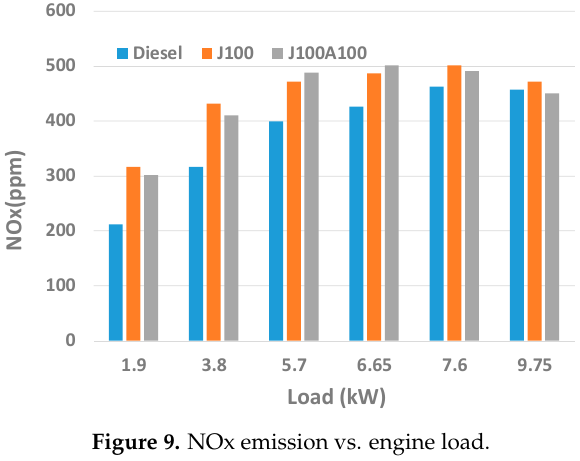
Figure 9. NOx emission vs. engine load.